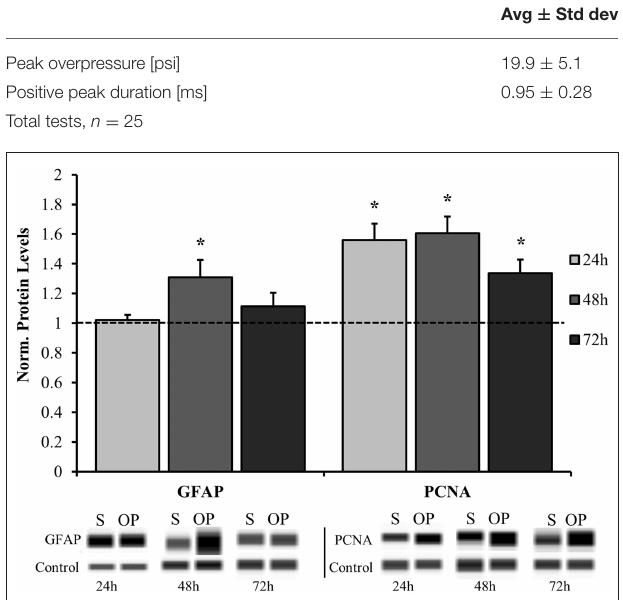
TABLE 2 | Summary of shock wave parameters.